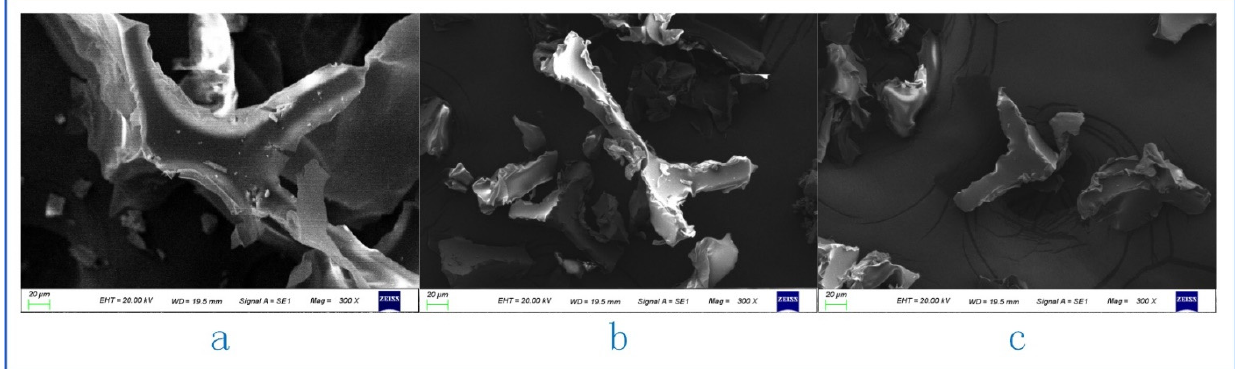
Figure 7. Microscopic morphology of PUF powders with different mesh numbers. ( a ) 40 mesh. ( b ) 80 mesh. ( c ) 120 mesh.